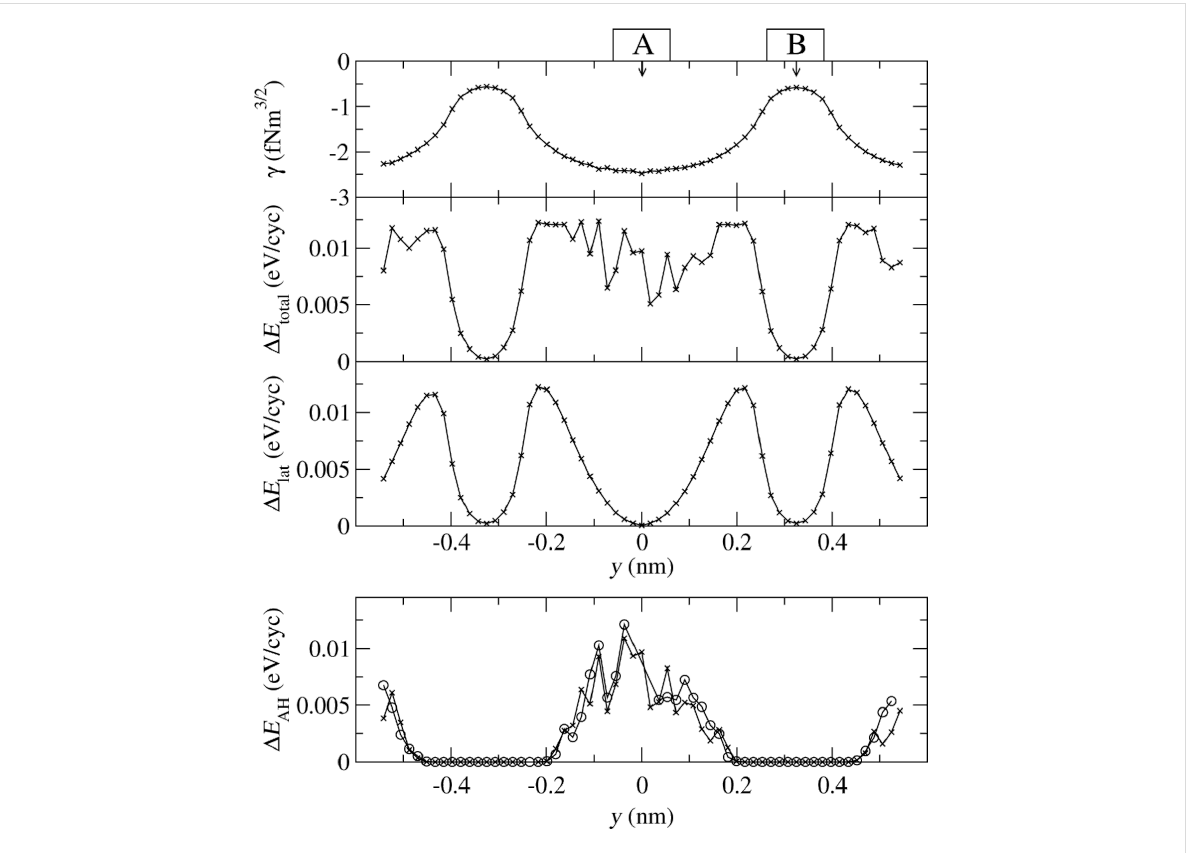
Figure 9: Simulated constant-height scan ( d = 0.4 nm) for KBr along the line shown in Figure 3. The first panel shows the frequency shift, the second shows the total damping rate Δ E total , which is composed of the damping rate due to lateral oscillations ( Δ E lat shown in the third panel) and due to adhesion hysteresis ( Δ E AH shown in the fourth panel). The fourth panel also shows the dissipation rate, if the excitation of lateral oscillations is suppressed (open circles).